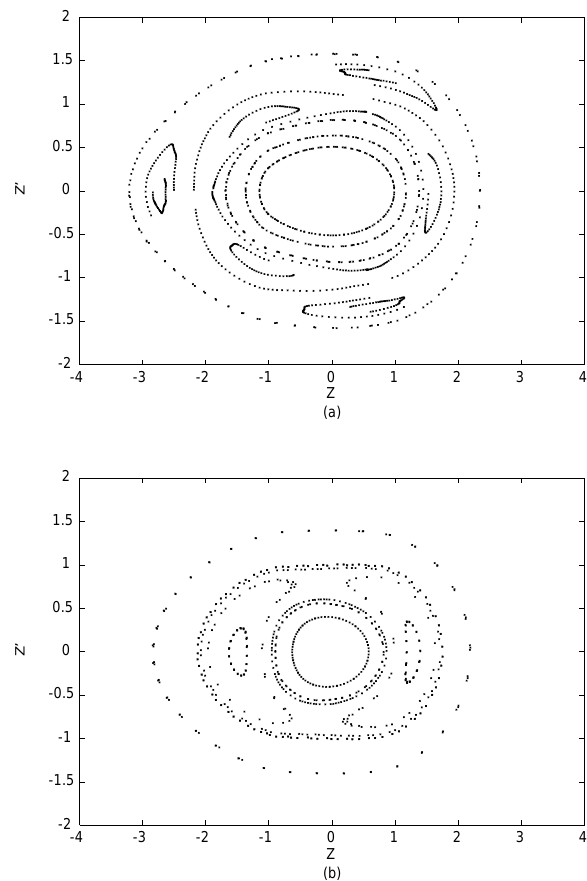
FIG. 11. The stroboscopic plot in the Z - Z 0 plane under (a) the high mode and (b) the low mode with a 5% initial transverse mismatch with focusing strength ratio k z 0 (cid:1) k x 0 (cid:1) 0.634